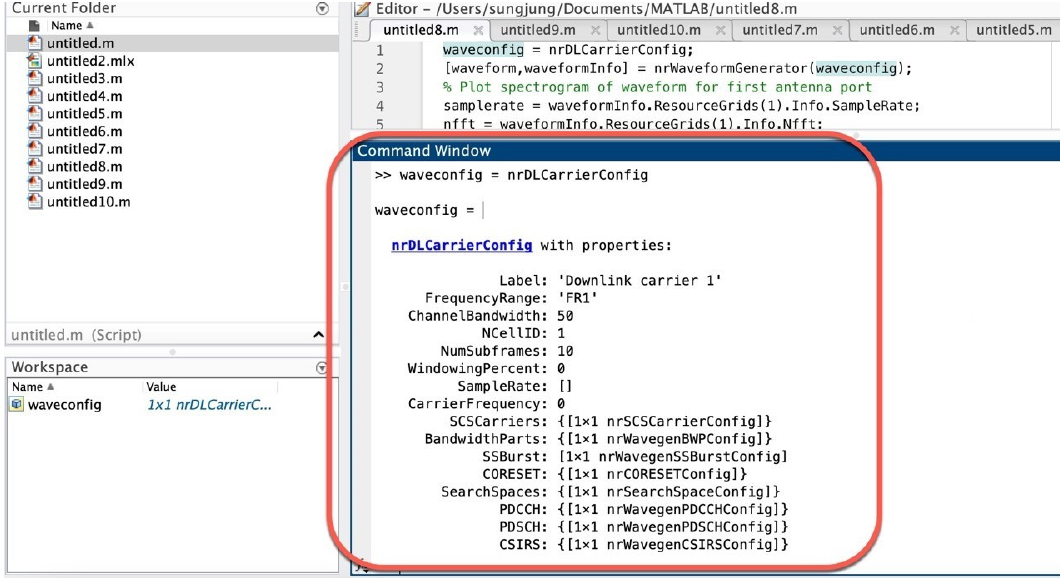
Figure A4. Code used to generate a 5G signal.